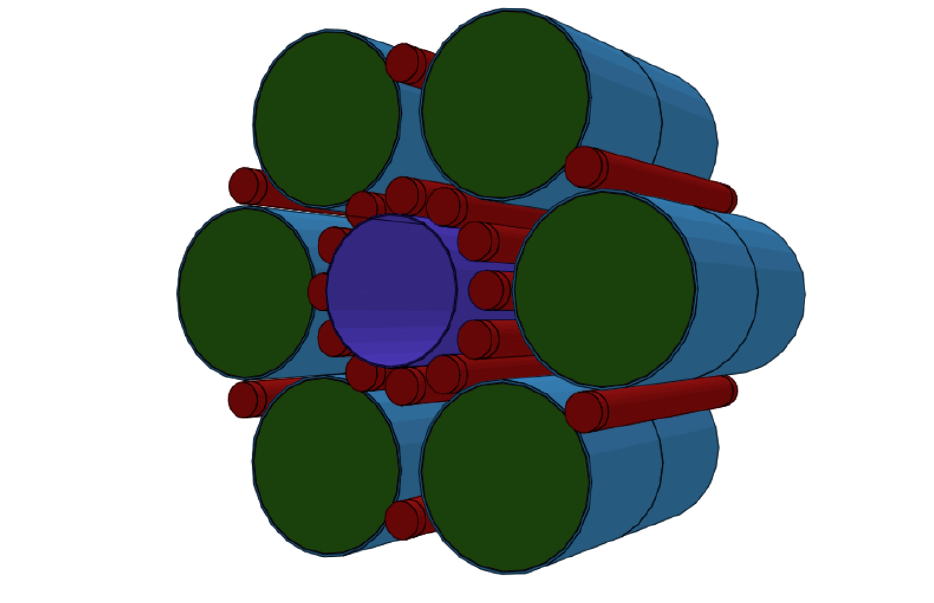
Figure 1. The SHADES detection array